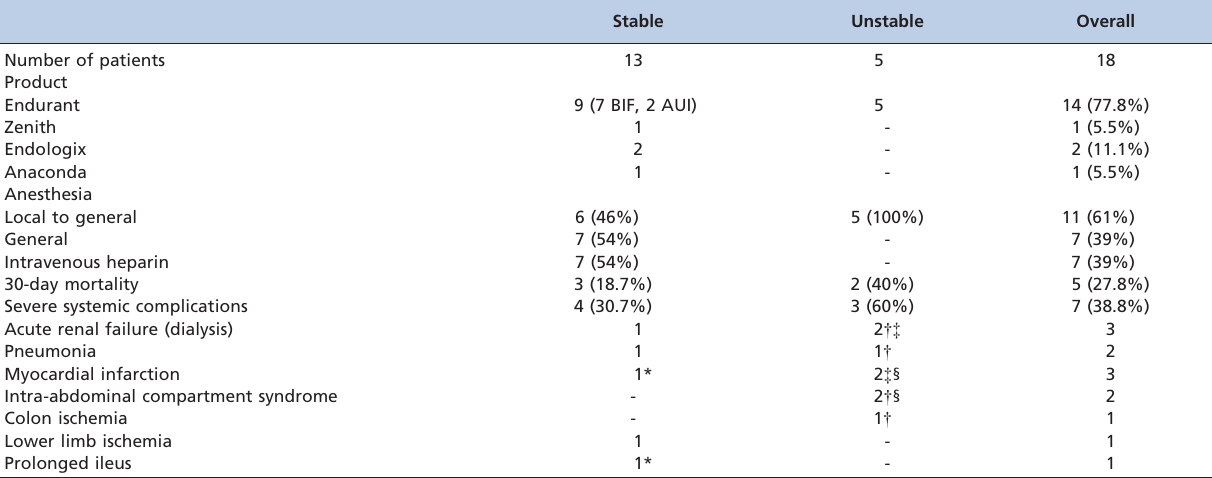
Table 2 - Summary of endovascular cases.